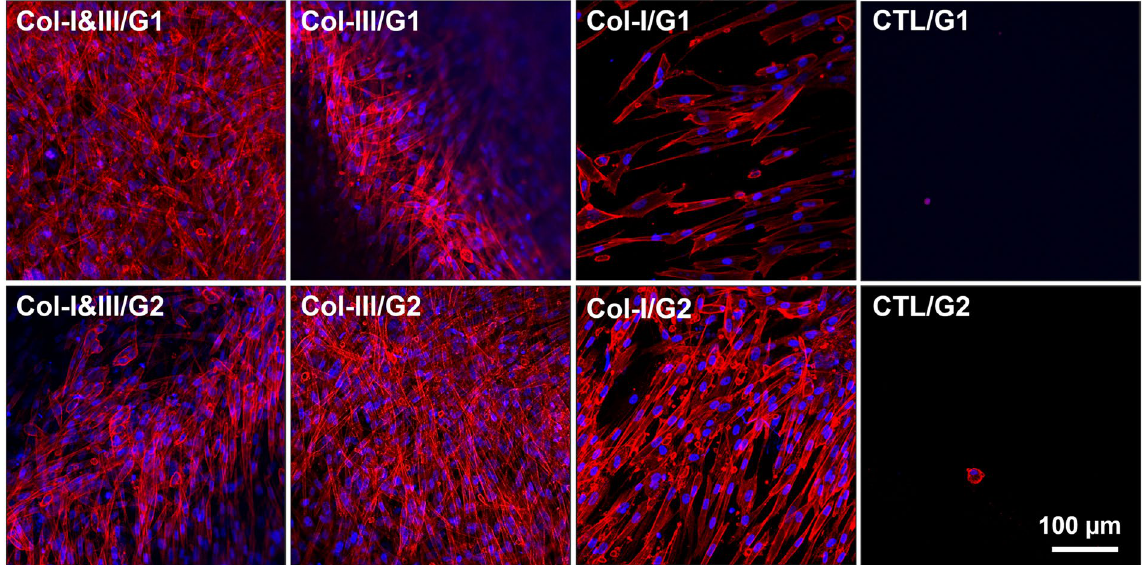
Figure 5. Representative fluorescent images of adherent cells cultured on the surface of the collagen (Col)/ glycol-chitosan (GCS) hydrogels and negative controls. Actin cytoskeleton and nuclei are shown in red and blue, respectively. Fibroblasts were attached strongly to the surface of the proposed Col/GCS hydrogels. The cells were spread out extensively, and the formation of actin stress fibers were observed. On the contrary, only a few rounded cells were found attached on the surface of the negative controls after 3 days. The images were captured with a 20x objective, and the scale bar shows 100 μ m (Col-III: collagen type III, Col-I: collagen type I, Col-I&III: both Col-I and Col-III, and CTL: negative controls. G1 and G2 represent the final GCS concentration of 2% and 1%, respectively).